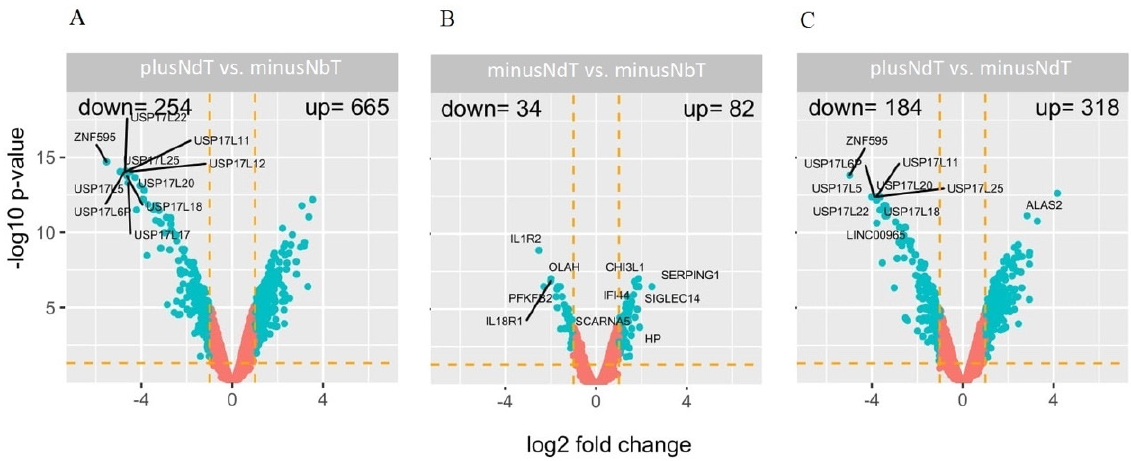
Figure 1. The volcano plot of global gene expression. Graphs ( A – C ) show comparisons with different groups. ( A ) patients with neuropathy during treatment (plusNdT) vs. the group of patients without neuropathy before treatment (minusNbT); ( B ) patients without neuropathy during treatment (minusNdT) vs. the group of patients without neuropathy before treatment; ( C ) patients with neuropathy during treatment vs. patients without neuropathy during treatment. Genes are represented by dots. The graphs show the genes with at least two-fold change and p < 0.05. The graphs also contain the symbols of the genes with the largest change in expression.